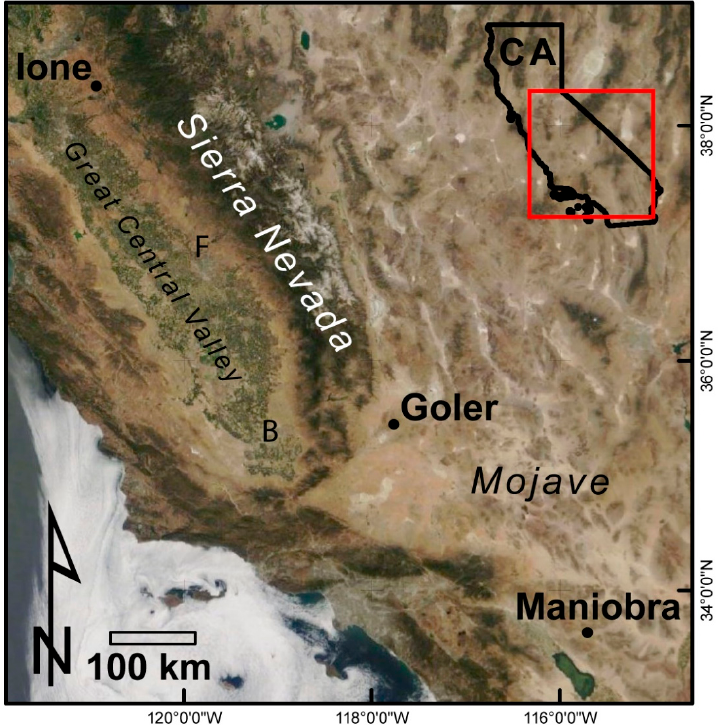
Figure 1. Regional index map. The basal Tertiary nonconformity extends roughly 1000 km in California, spanning a wide range of present-day climatic and physiographic milieus. The Ione, Goler, and Maniobra sites sample three distinct localities of this complex geological feature. F: Friant, CA. B: Bakersfield, CA.